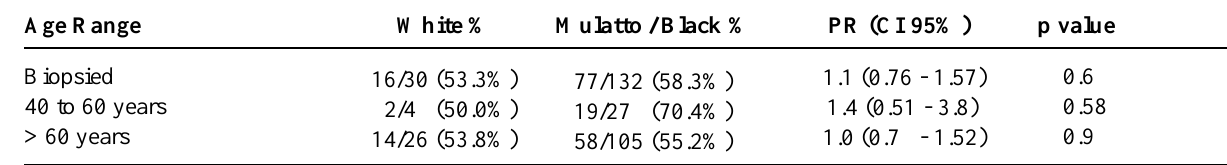
RP = razão de prevalência; IC = intervalo de confiança.